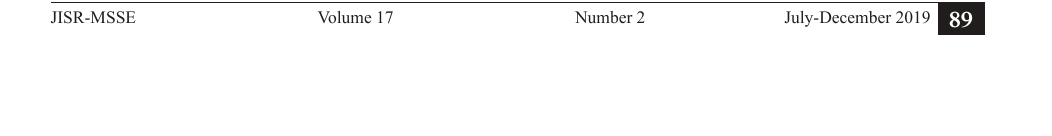
Figure 2: Number of respondents according to Public universities